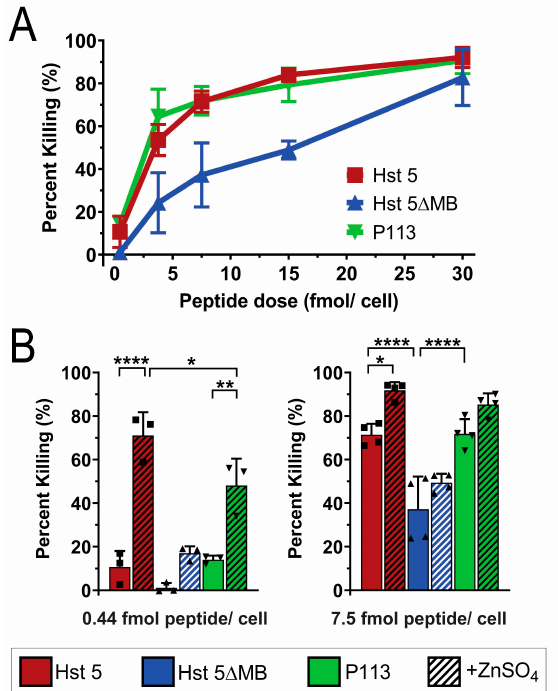
Figure 3. Hst 5 Δ MB has less killing activity than Hst 5 or P113 and does not have increased killing activity with added Zn 2+ . ( A ) Candidacidal assays of C. albicans SC5314 cells with 1 h incubation at 30 ˚ C of Hst 5 (red), Hst 5 Δ MB (blue), and P113 (green) at dosages of 0.44, 3.75, 7.5, 15, and 30 fmol/cell in 10 mM sodium phosphate buffer pH 7.4. Data represent at least two replicates for each dose. ( B ) Candidacidal assays of C. albicans SC5314 cells with 1 h incubation at 30 °C of Hst 5 (red), Hst 5 Δ MB (blue), and P113 (green) with and without a 1:2 ratio of Zn 2+ : peptide (hatched) at dosages of 0.44 fmol/cell (left) and 7.5 fmol/cell (right) in 10 mM sodium phosphate buffer pH 7.4. Squares and triangles indicate individual replicates. Significance of differences in killing activity were calculated using one way ANOVA with Sidak’s multiple comparisons test. * indicates p ≤ 0.05, ** indicates p ≤ 0.01, *** indicates p ≤ 0.001, **** indicates p ≤ 0.0001.